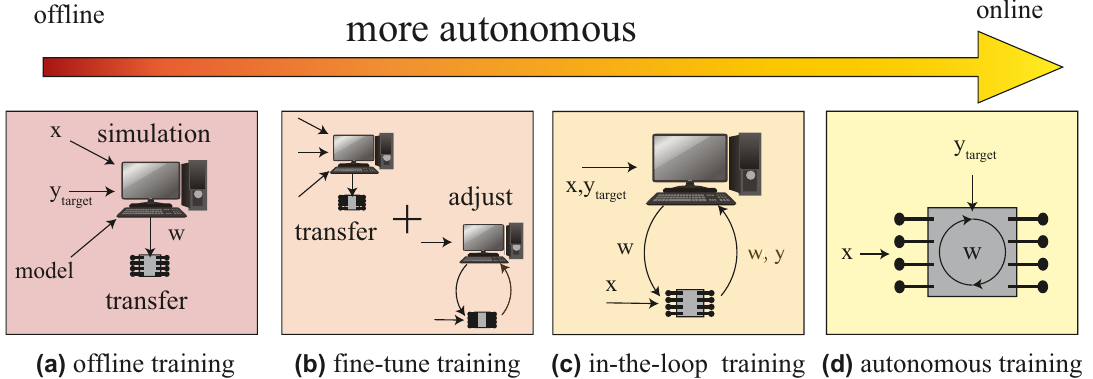
Figure 1: Training on photonic hardware ranging from fully offline to fully online. (a) Offline training, where a model of the physical system and the training dataset are trained on a computer, and the weights are transferred to the device. (b) “Fine-tune training”, where the system is trained as in (a), but the weights are adjusted to improve the accuracy after transfer to the device. (c) Hardware-in-the-loop involves measuring the chip during training, but some portion of the calculations for training still happen on a computer. (d) Fully autonomous online learning. In this case, only the training dataset is input to the device, which can adjust its weights autonomously as it